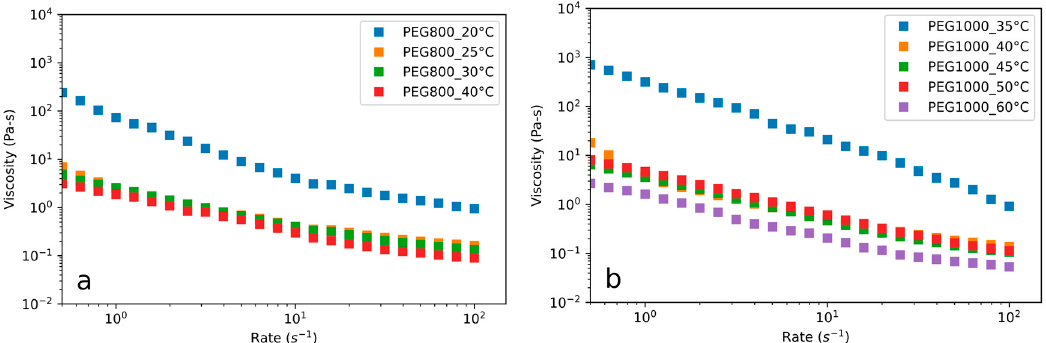
Figure 1. Viscosity vs. shear rate curves recorded at different temperatures of ( a ) PEG 800; ( b ) PEG 1000. ( b ) PEG